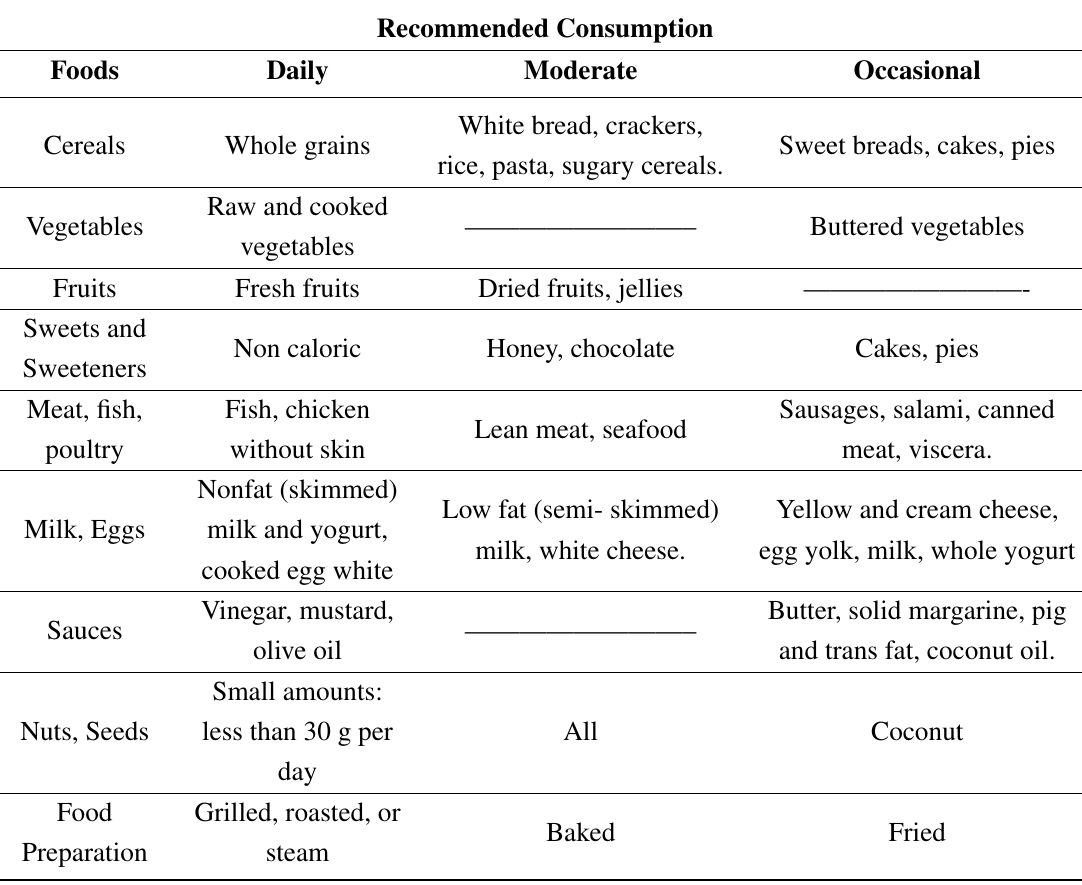
Table 11. Brazilian Cardiology Society Nutritional Recommendations for